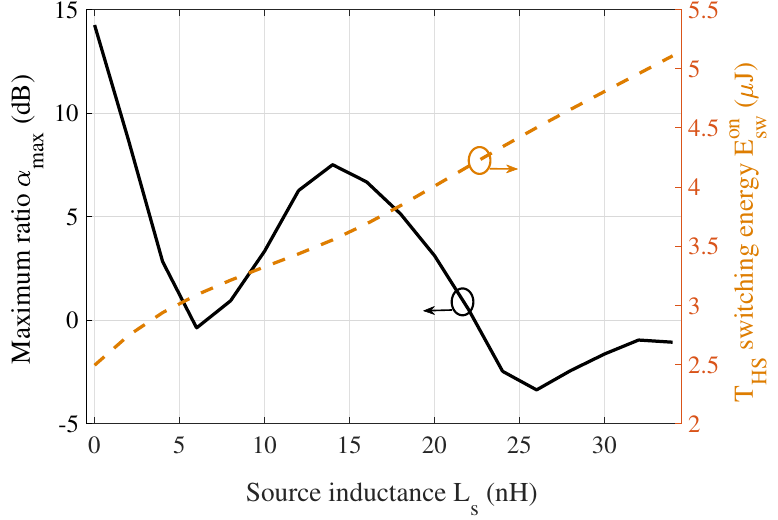
Figure 9. Switching energy related to T HS during its turn-on (dashed line) and the maximum ratio between the v sw and the ideal trapezoidal waveform